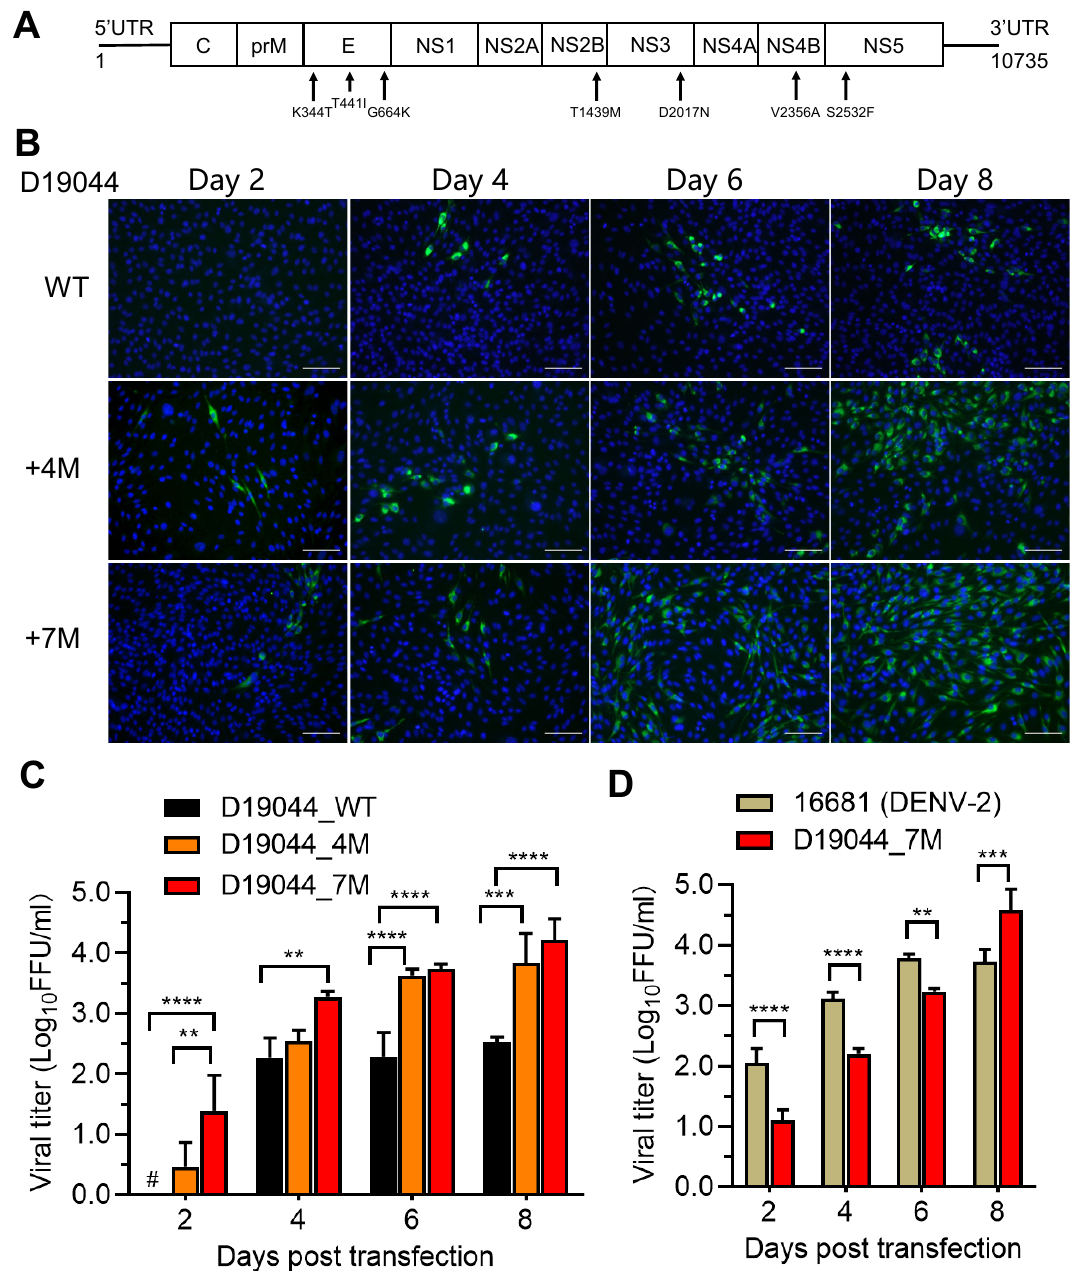
Figure 3. Amino acid substitutions improved the virus production of D19044 clone. ( A ) Diagram of DENV-1 genome with seven amino acid substitutions (7M) identified from passage-recovered viruses. ( B ) IFA of D19044_WT, D19044_4M, and D19044_7M after plasmid transfection of BHK-21 cells. DENV-1 NS3 protein (green) and cell nuclei (blue) were visualized. Bar, scale 100 μm. ( C ) The DENV titer of culture supernatant. Three D19044 clones (D19044_WT, _4M, and _7M) were transfected into BHK-21 cells, and the supernatant were collected for FFU assay at time points as indicated. The means ± SEM of three independent experiments are shown. A “#” indicates the titer was below LOD (<0.69 log 10 FFU/mL). ( D ) Comparison of viral titers released by D19044_7M and DENV-2 clone 16681. BHK-21 cells were transfected with D19044_7M and DENV-2 16681 plasmids, and the supernatant were collected for FFU assay at time points as indicated. The means ± SEM of three independent experiments are shown. In panels C and D , statistics analyses were performed using multiple comparison test in a two-way ANOVA. ** p < 0.01; *** p < 0.001; **** p <